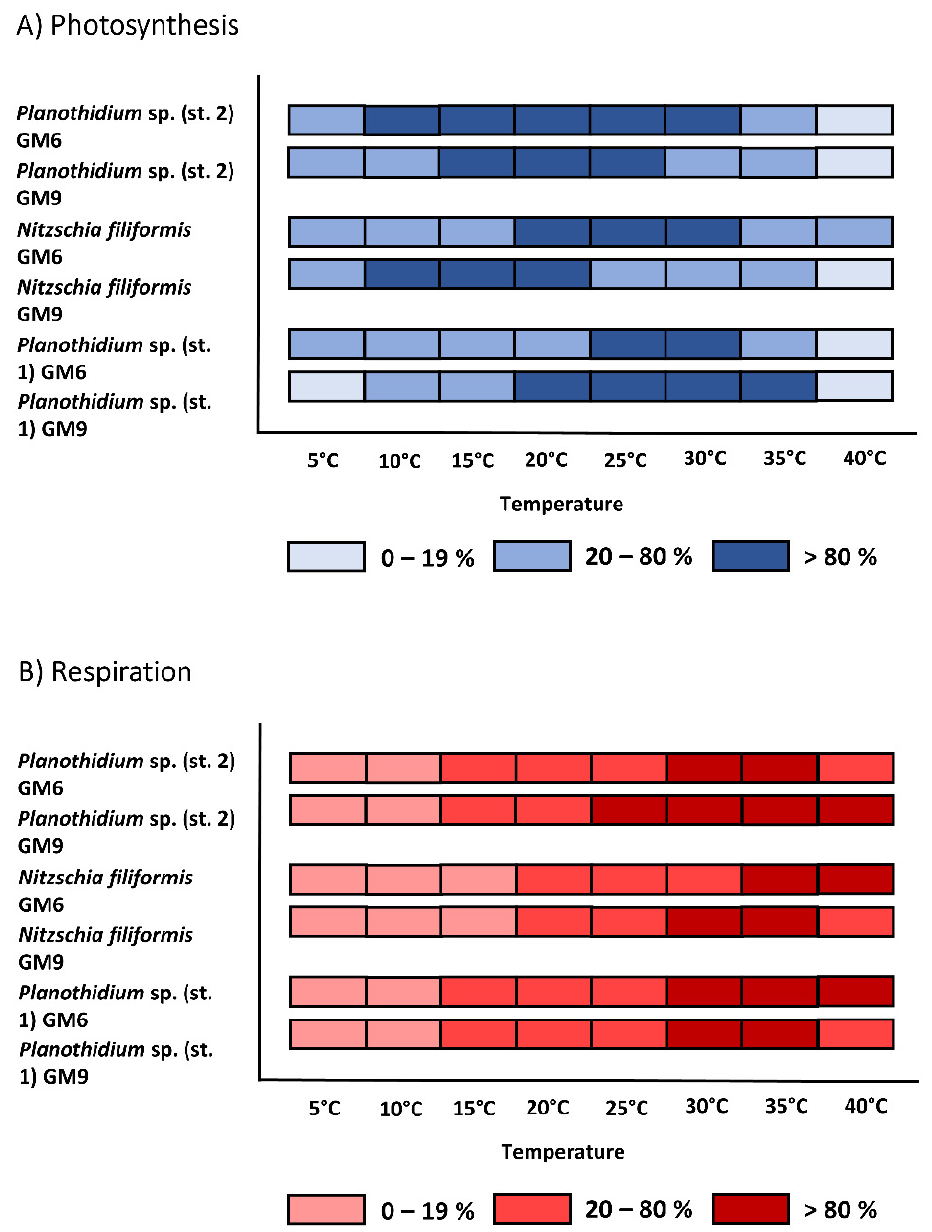
Figure 8. Effect of temperature on ( A ) photosynthetic oxygen evolution and ( B ) respirational oxygen consumption of three peatland benthic diatom strains in two different cultivation media (GM6 and GM9). Dark blue/red symbols represent highest photosynthesis at >80% percentile, medium blue/red symbols within 20 and 80% percentile and light blue/red symbols < 20% percentile. Data represent mean values (n = 3).